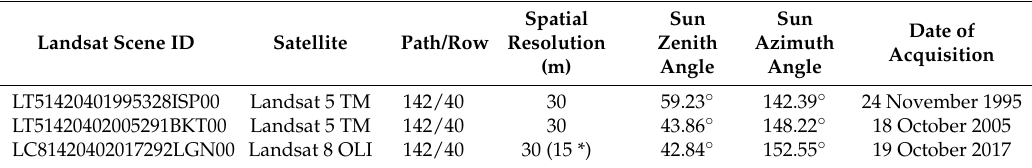
Table 1. Details of Landsat data and the corresponding solar